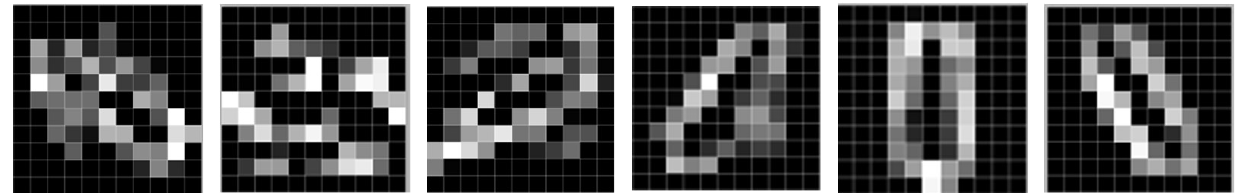
Figure 5. Diagram of six templates with different directions in Fourier module.